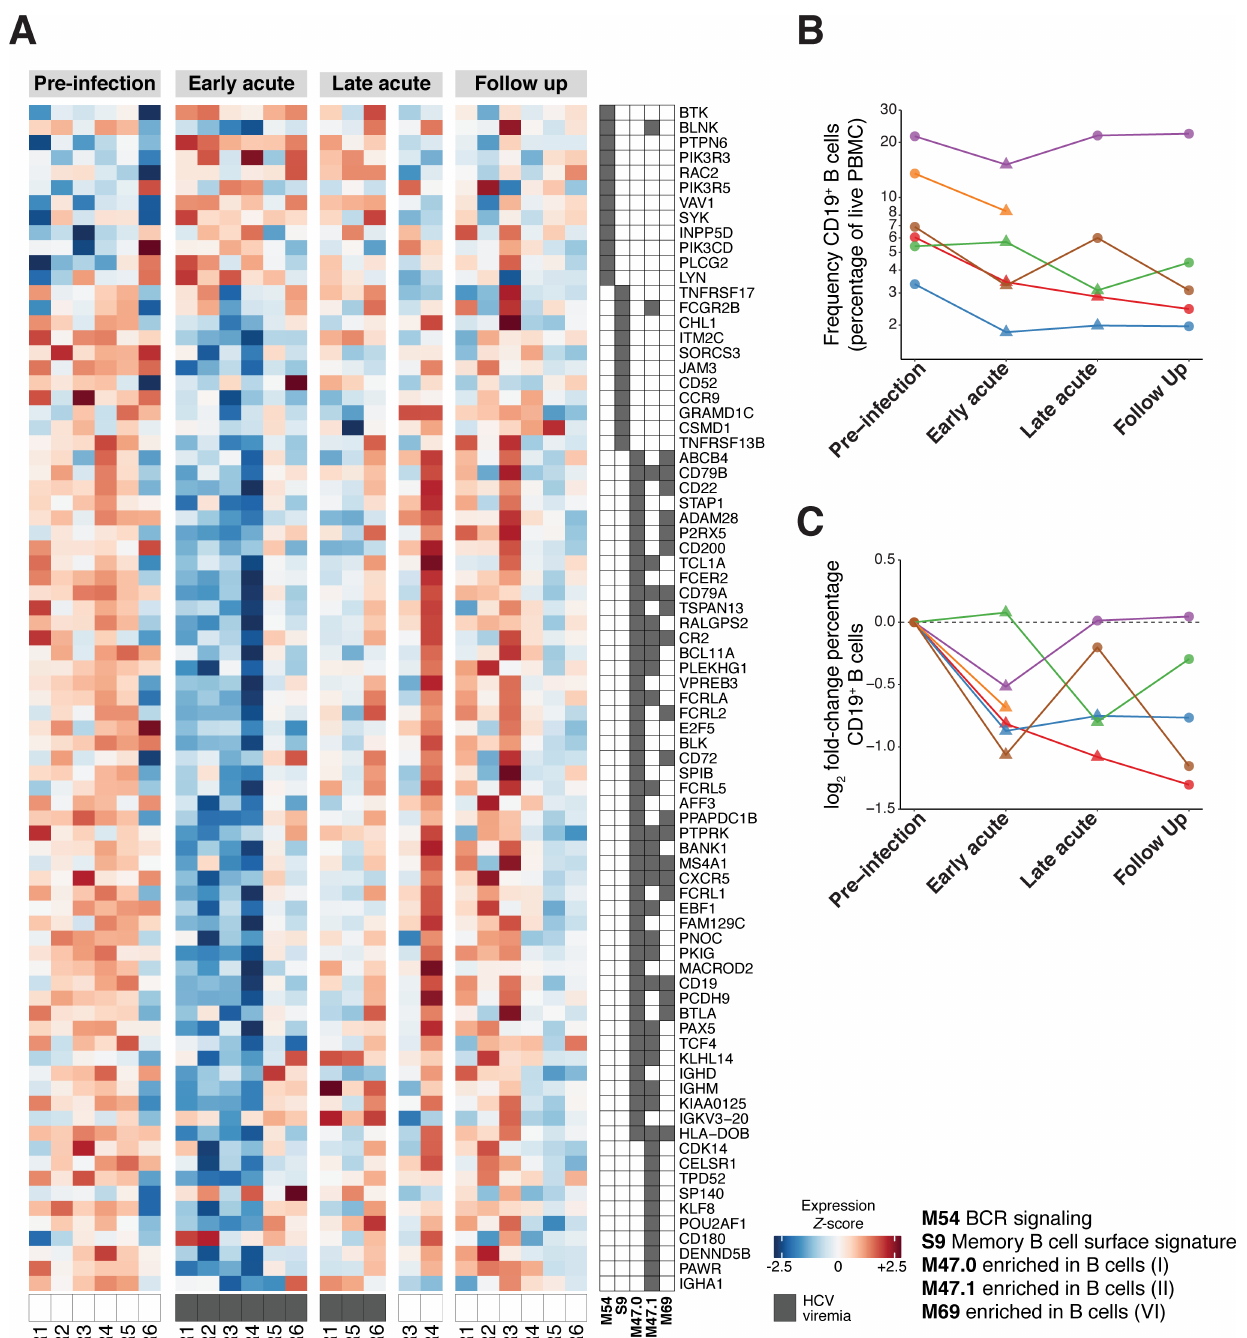
Fig 4. Decreased B cell transcriptional signatures in acute HCV infection. (A) Heatmap displays individual patient sample scaled expression values (normalized log 2 read counts per million, scaled to z-scores by gene) for expressed genes composing select B cell-associated BTMs. BTM gene membership is denoted in accompanying grid annotation. Dark grey boxes along bottom of heatmap indicate detectable HCV viremia. (B) CD19 + B cell frequency (percentage of live PBMC as measured by flow cytometry) at indicated time points during acute HCV infection and resolution. Each color (points/lines) denotes data from a single patient. Y-axis on log 10 scale to facilitate visualization across different patients. (C) Log 2 fold-change (relative to corresponding patient pre-infection baseline) of CD19+ B cell frequency (percentage of live PBMC as measured by flow cytometry) at indicated time points during acute HCV infection and resolution. Each color (points/lines) denotes data from a single patient.